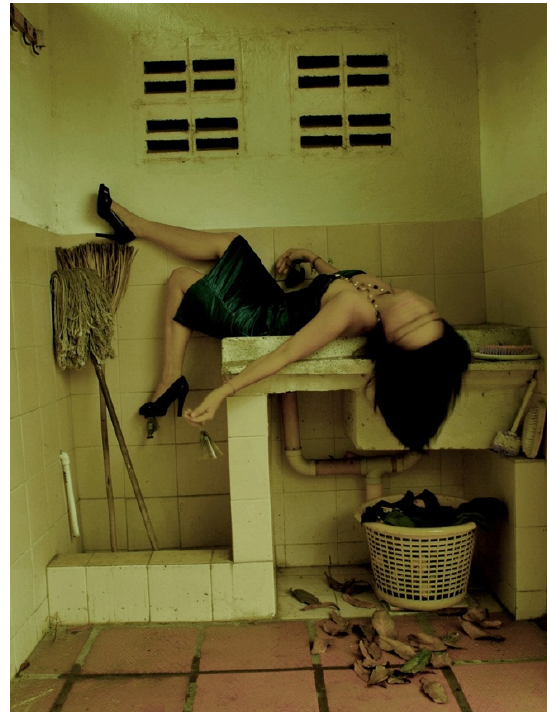
Figure 1. Raisa Galofre, Autoficciones (series), 2010—image provided by the artist. Women like Raisa Galofre (Barranquilla 1986) feel that a particular and yet very diverse oppression is still present in women’s lives all over the world, even as they are divided by class and income. The body of a woman is a sign of difference that always remains marked as an ideal, even when its leisure and wealth are supported or made possible by the labor of other women. Representations of women like this signal a crack, a symbolic cleft